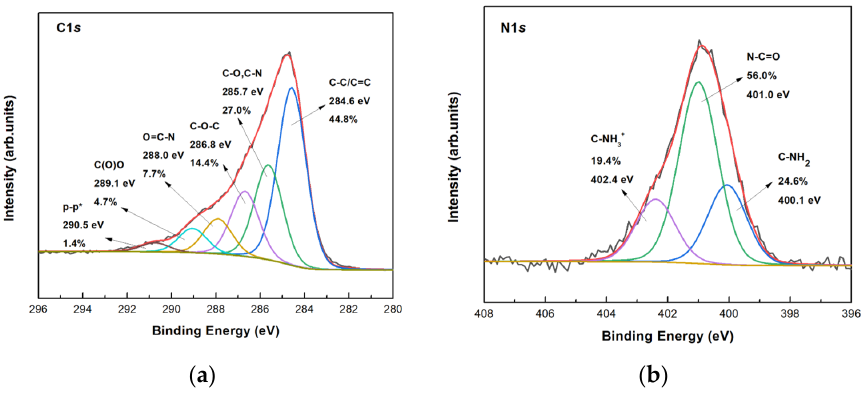
emission of the photoelectron, mainly on the phenyl groups of BSA and graphene. The detailed XPS spectrum of the N1 s core level region in Figure 6b contains contributions from NH 2 (BE = 400.1 eV), peptidic nitrogen (BE = 401.0 eV), and NH 3+ (BE = 402.4 eV.) [27].